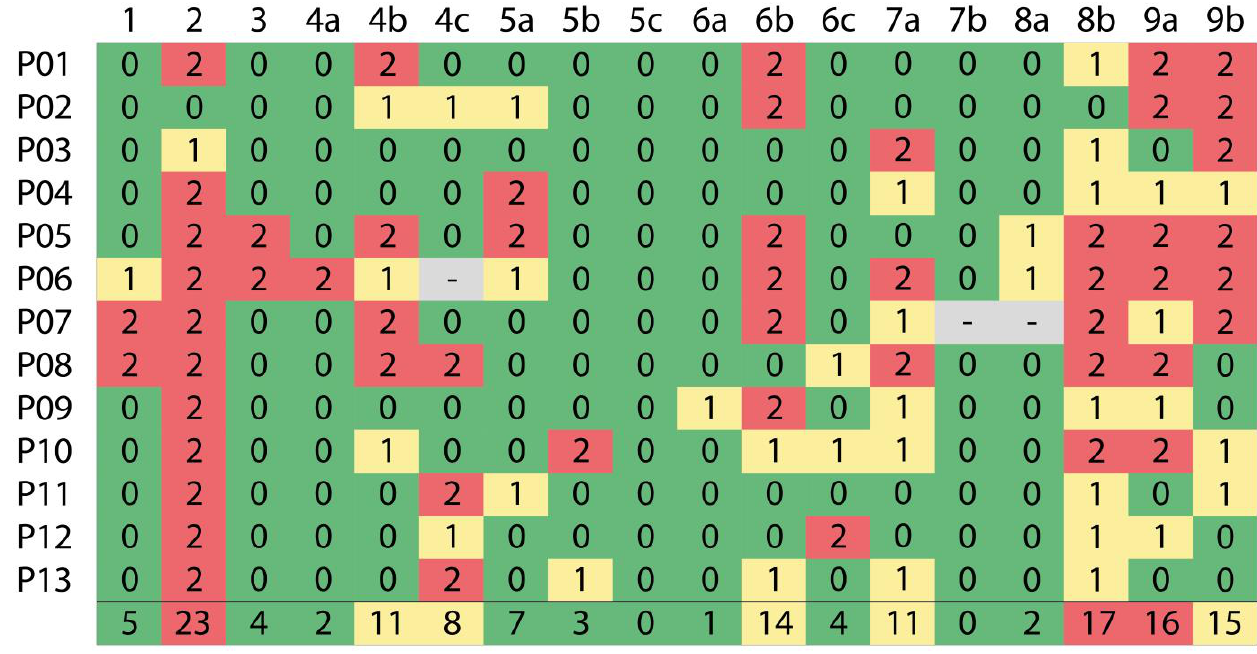
Figure 8. Error rate.